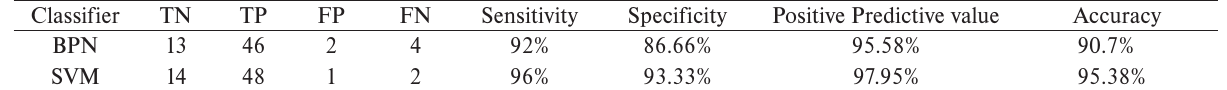
Table 3. Analysis of classification results (Fundus image features).